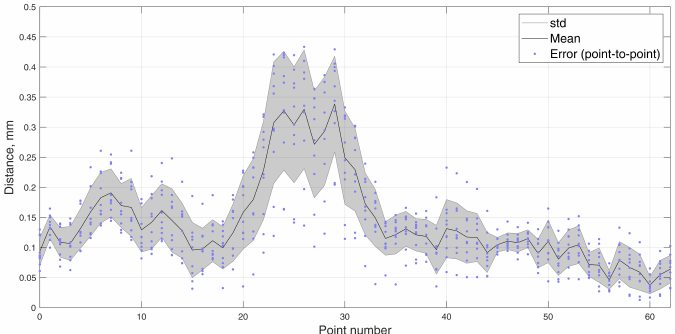
Figure 13. Error (point–to–point) of every measured point in 10 iterations of the masticatory test trajectory in the static positioning test, with the mean and standard deviation.